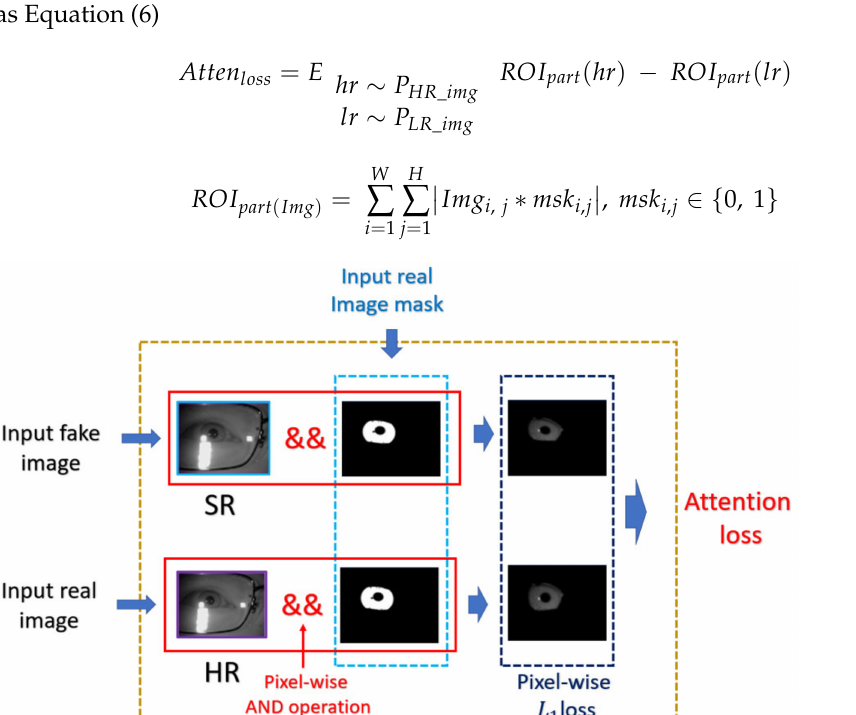
Figure 8. Attention module and the corresponding loss in the proposed